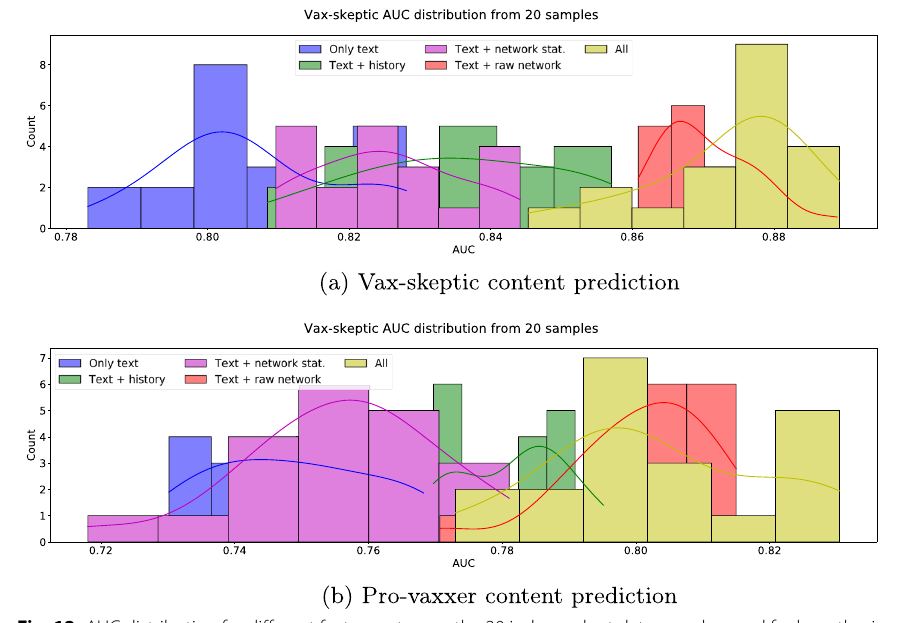
Fig. 12 AUC distribution for different feature sets over the 20 independent data samples used for hypothesis testing